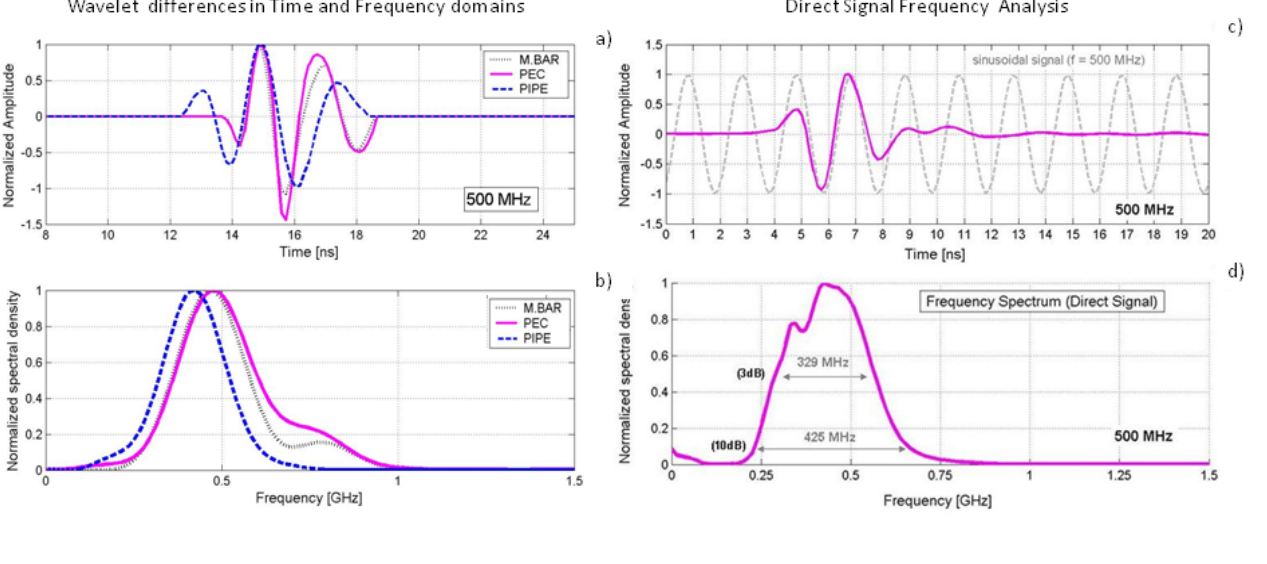
Figure 12. (a) Wavelet differences in the time domain. (b) Wavelet differences in the frequency domain. (c-d) Frequency analysis of the direct signal between dipoles.